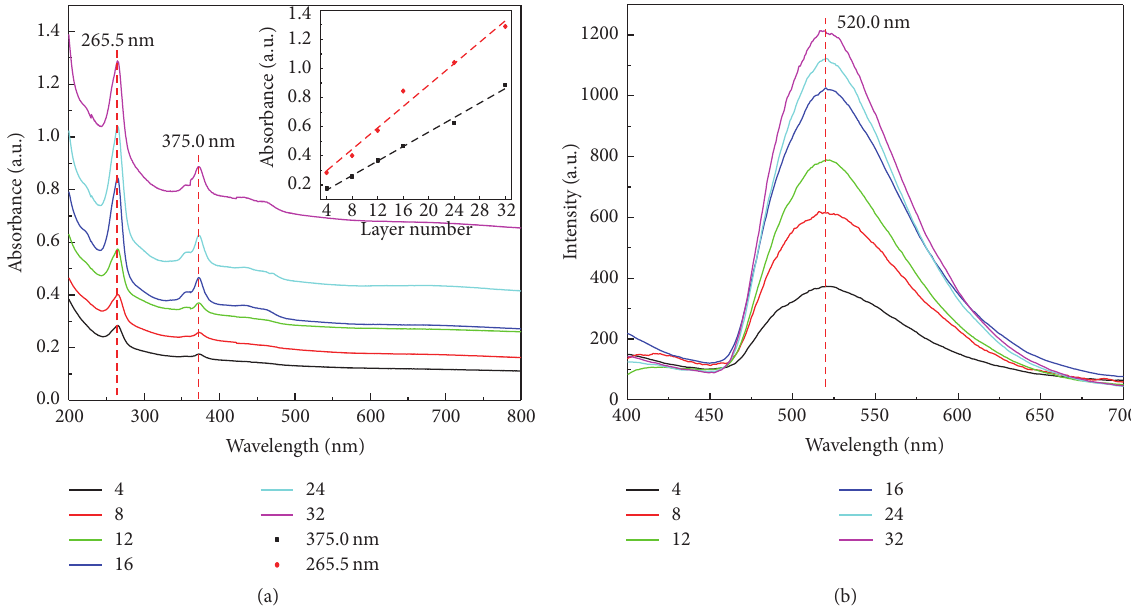
Figure 2: UV-visible absorption spectra and photoluminescence spectra of MgM( 𝑛 )-films. The inset (a) shows the absorbance increasing linear relationship in 265.5 nm and 375.0